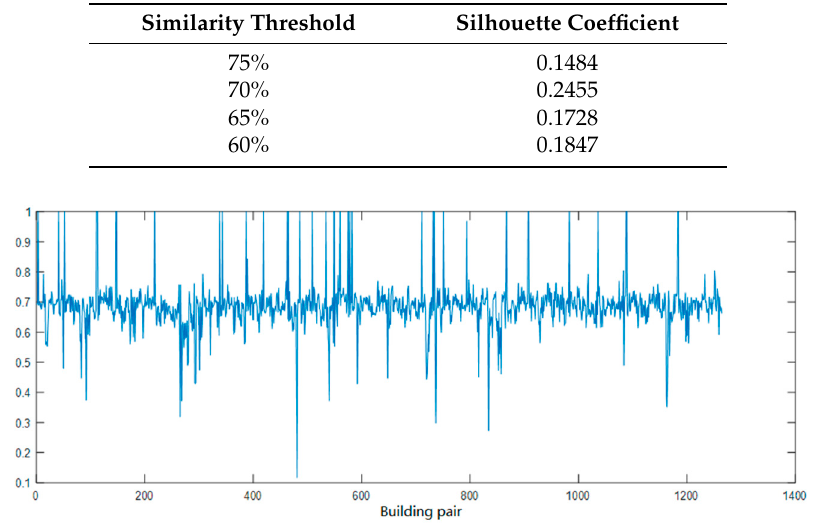
Figure 7. The whole similarity between polygon pairs in experimental region a .